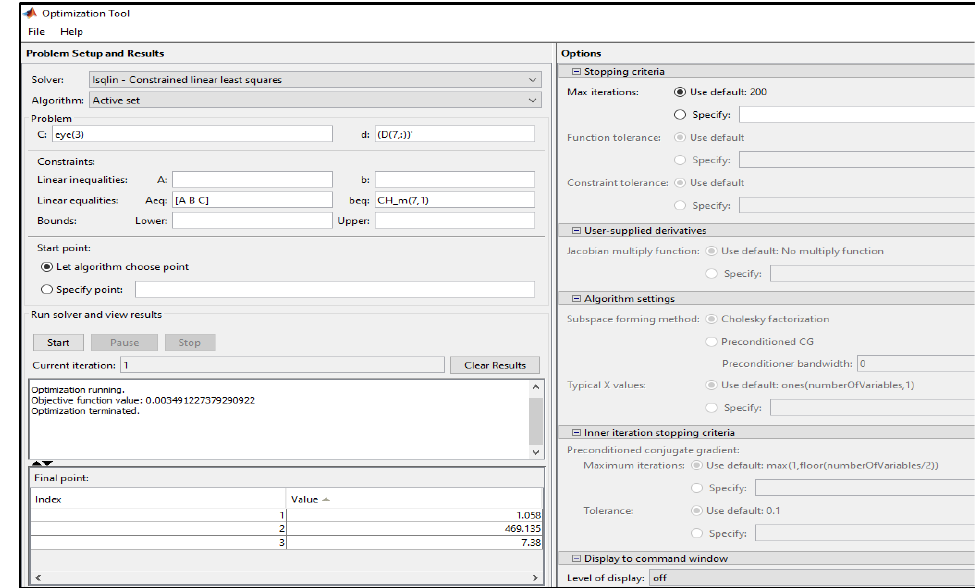
Figure 2. Optimization of a model predictor to optimize methane production in the biogas digester.